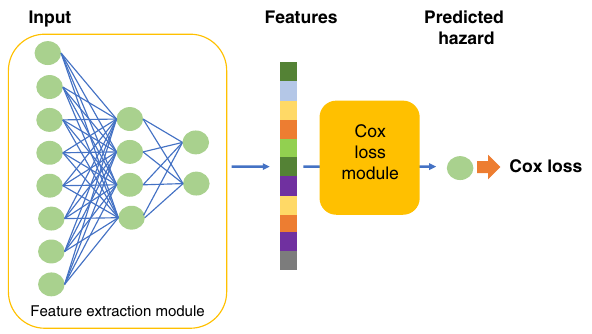
Fig. 1 Schematic showing the survival prediction model architecture. The model consists of a feature extraction module, and a Cox loss